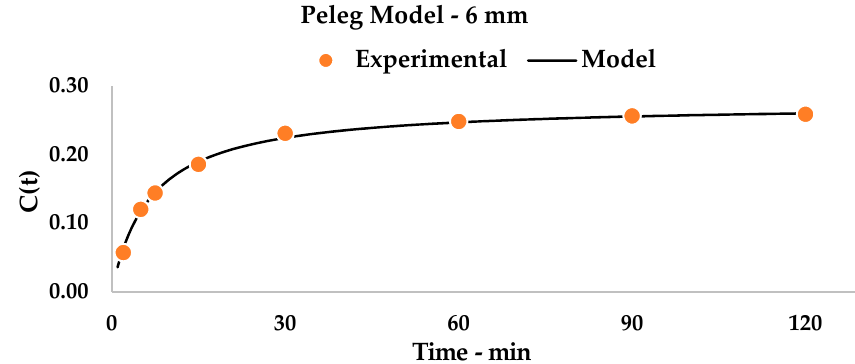
Figure 2. Kinetic Model, 6 mm matrix. Statistical values are reported in Table A1.